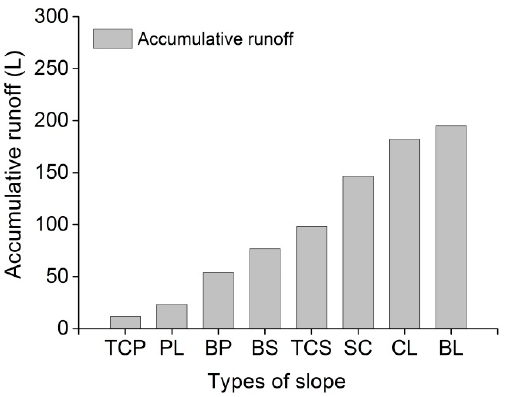
Figure 6. Accumulative runoff under different vegetation cover and tillage.